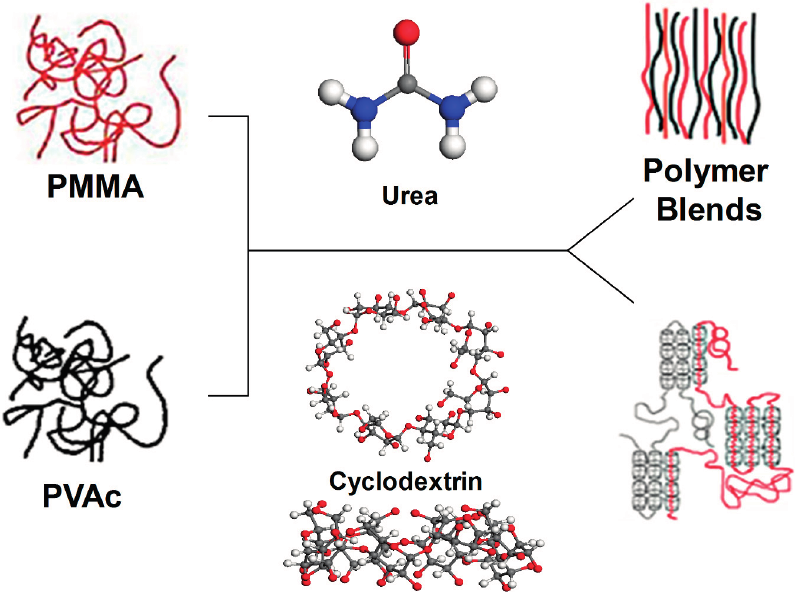
Figure 7. Comparison of blending poly(methyl methacrylate) (PMMA) and poly(vinyl acetate) (PVAc) via coalescence from stoichiometric U-IC and formation of (n-s)- γ -CD-ICs